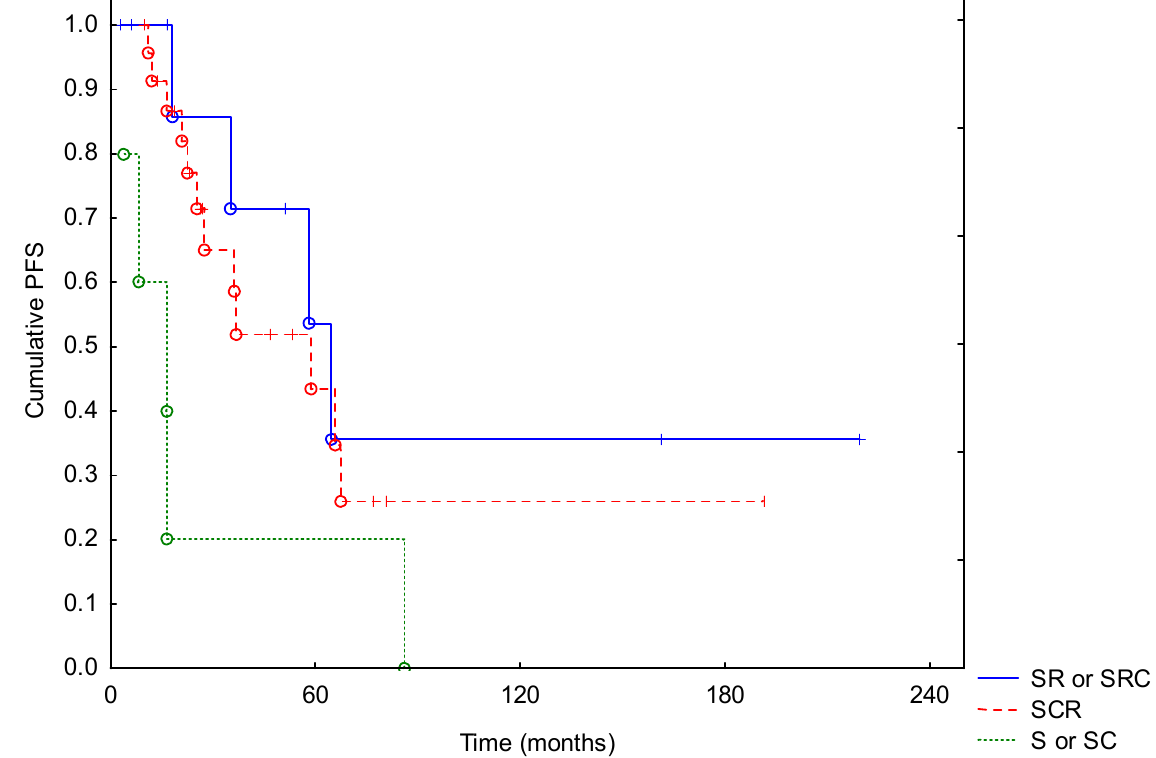
Figure 2. Progression-free survival (PFS) based on the sequence of primary treatment applied in patients with grade III tumours (SRC—surgery + RTH + CTH; SR—surgery + RTH; SCR—surgery + CTH + RTH; S—surgery; SC—surgery + CTH). Abbreviations: CTH—chemotherapy; RTH—radiotherapy.